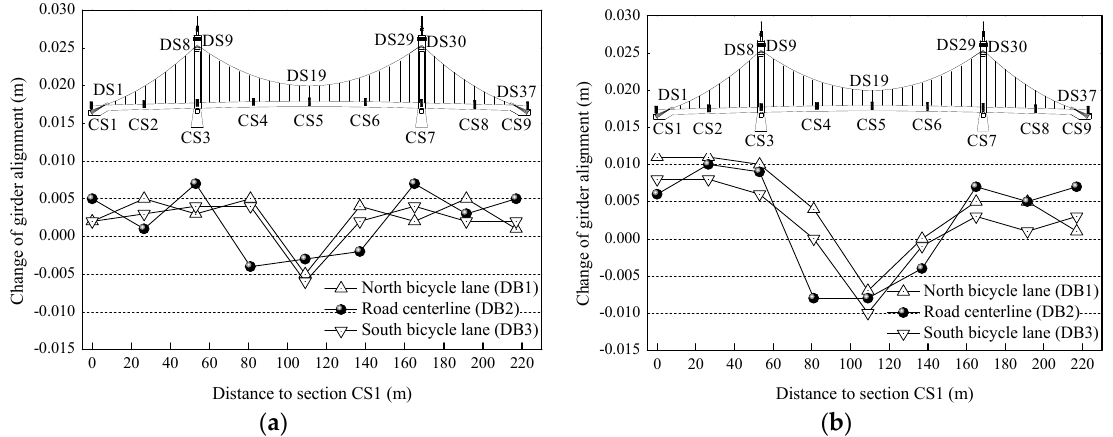
Figure 8. Measured changes of girder alignments during the one-year period from April 2015 to April 2016: ( a ) First half year period; and ( b ) One-year period.